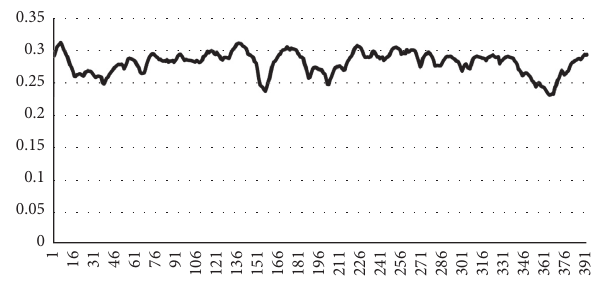
Figure 2: Dynamic correlation result.